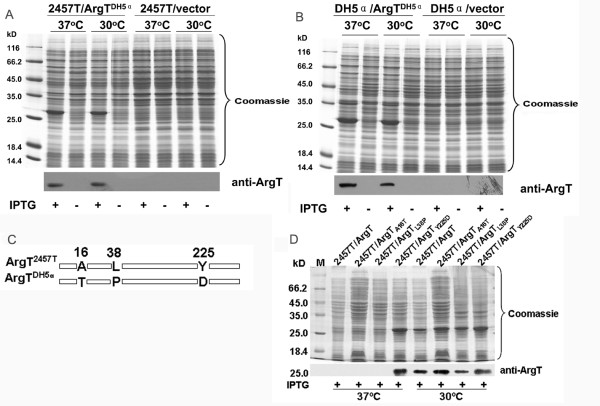
Identification of the key site of 2457T ArgT (tyrosine residue in position 225) for the regulation of expression. ArgTDH5α over-expressed in 2457T (A) and in DH5α (B) could be detected either at 37°C or at 30°C. (C) The three corresponding different sites between the protein sequence of ArgT2457T and ArgTDH5α. (D) Comparison of ArgT over-expressed in four strains carrying different plasmids at 37°C and 30°C. The plasmids include pProEX-HTb-argT2457T (ArgT) and its site-mutated plasmids ArgTA16T, ArgTL38P and ArgTY225D. M: protein marker (Fermentas, UK).